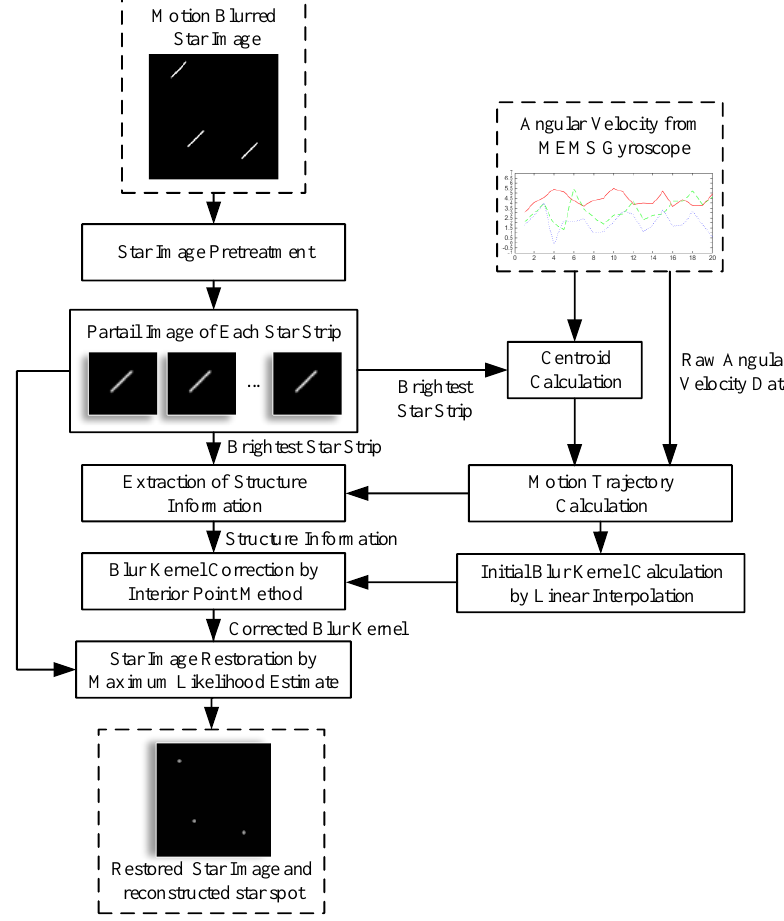
Figure 3. The flowchart of proposed method